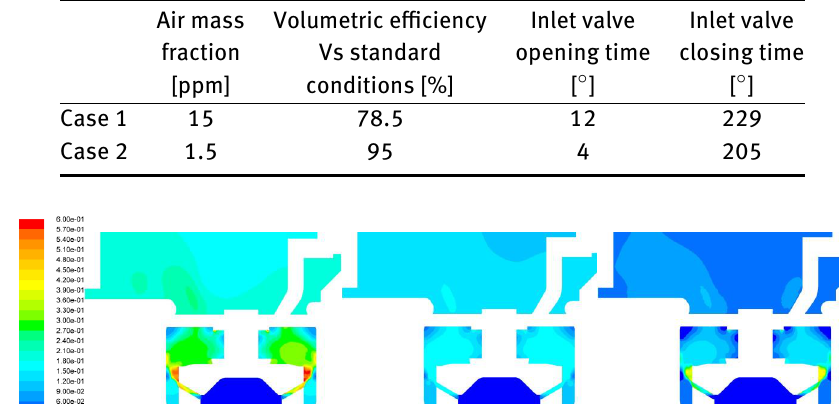
Figure 11 . Case 1 (15 ppm air mass fraction) at 120° of crank rotation . (left) total second phase Case 1 (15 ppm air mass fraction) at 120 ∘ of crank rotation: (left) total second phase volume fraction; (middle) air volume fraction; volume fraction. (middle) air volume fraction. (right) vapour volume fraction. Figure 11: (right) vapour volume fraction.